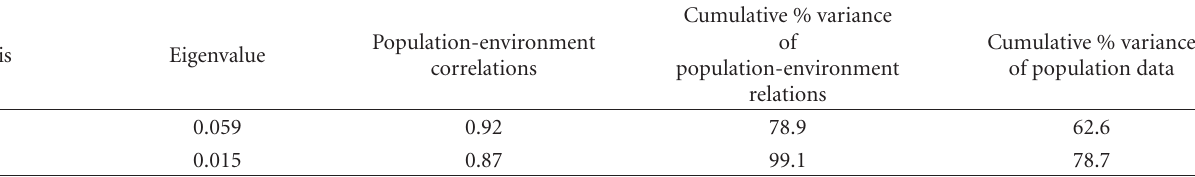
Table 6: Relationship among morphological variation in iroko populations and environmental factors, derived from CCA.